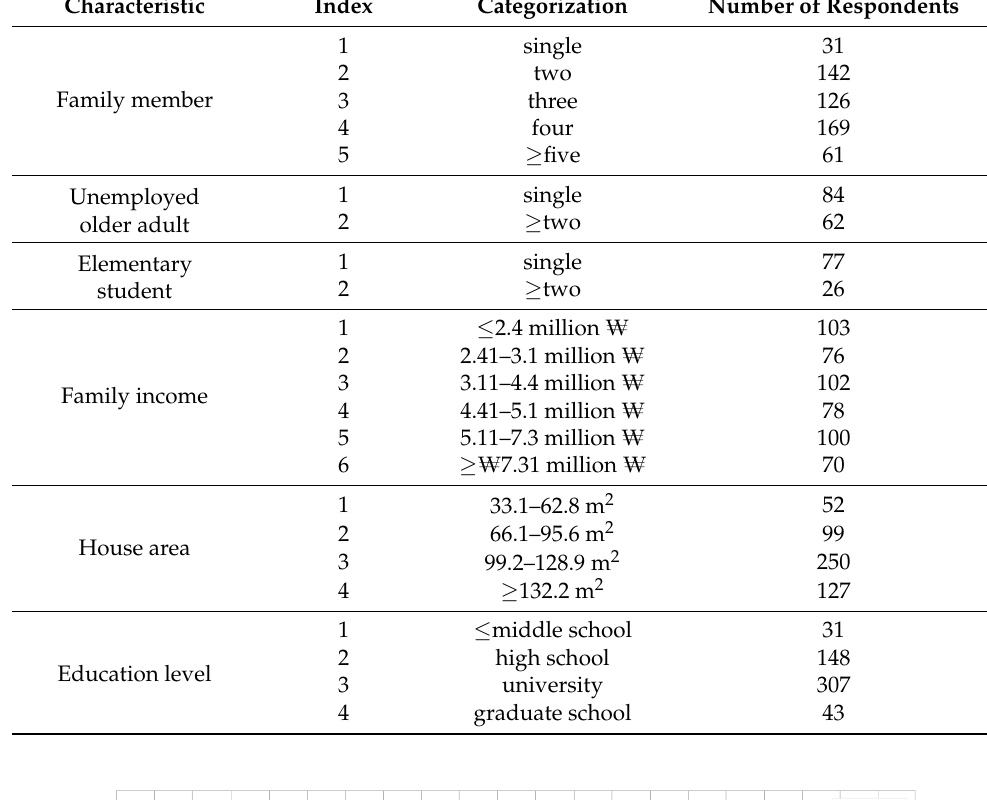
Table 3. Summary of residential customers in this study.